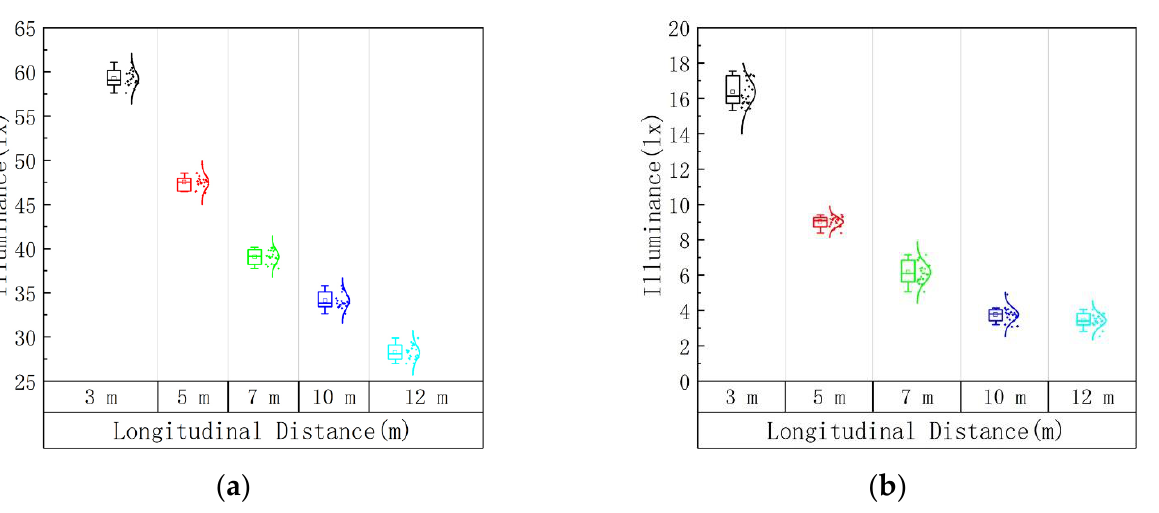
Figure 12. Distribution of illuminance thresholds under different longitudinal distances: ( a ) DGIG; ( b ) IGAG. Table 5. Illuminance thresholds of DGIG and IGAG at different longitudinal distances (0–12 m). Longitudinal